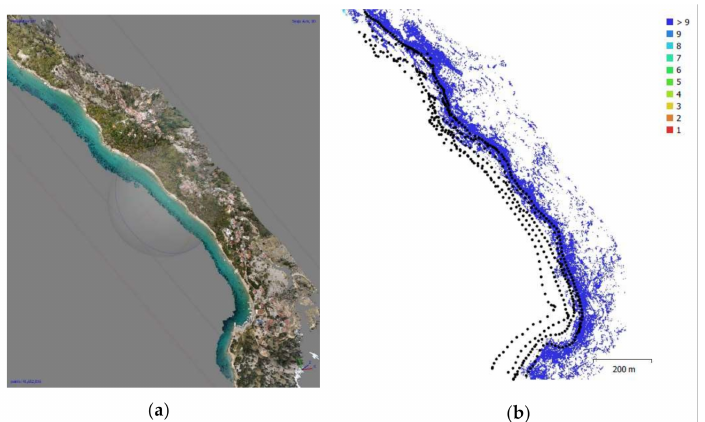
Figure 3. Agisoft Metashape Processing Report: ( a ) Investigated area 3D Point cloud, ( b ) camera locations and number of image